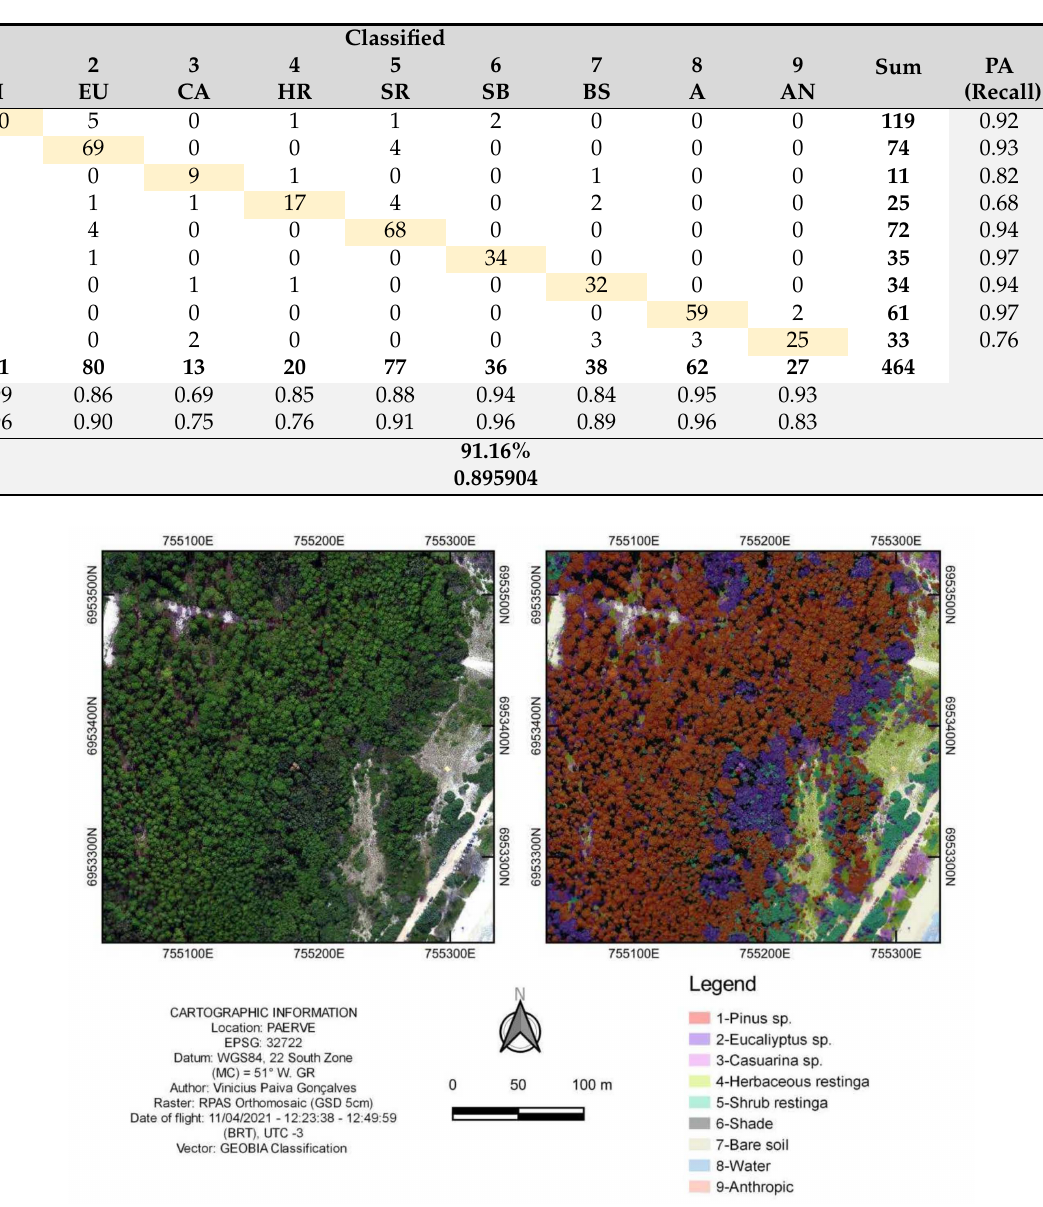
Table 10. Confusion classification matrix for the PAERVE area. The rows represent the reference map, and the columns represent the classified map. The classes are 1— Pinus sp. (PI), 2— Eucalyptus sp. (EU), 3— Casuarina sp. (CA), 4—herbaceous restinga (HR), 5—shrub restinga (SR), 6—shade (SB), 7—bare soil (BS), 8—water (A), and 9—anthropic area (AN). The table also includes the measures of producer accuracy or recall (PA), user accuracy or precision (UA), F-score, global accuracy (GA), and kappa Cohen index (K).